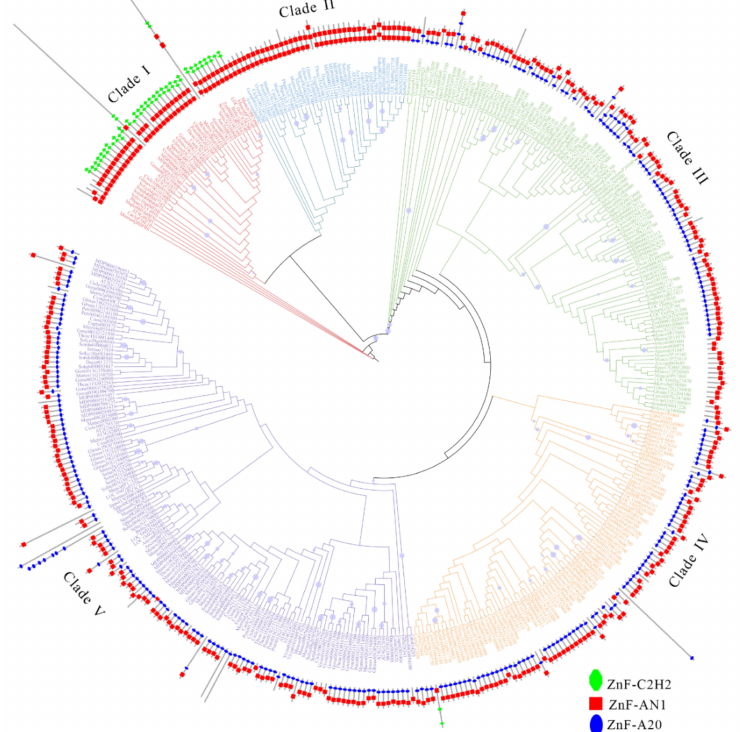
Figure 5. The maximum likelihood evolutionary tree was established for the selected SAPs, which contains 29 selected species and 4 outgroup species and their protein domains. Abbreviation of the species name can be found in Table S1. The Figure can be divided into five clades, and different clades are shown in different colors. Red, blue, green, orange, and purple represent clades I to V, respectively, while the topological structures on the domains are also marked, with blue ellipses representing the AN1 domain, red cuboids representing the A20 domain, and green ellipses representing the C2H2